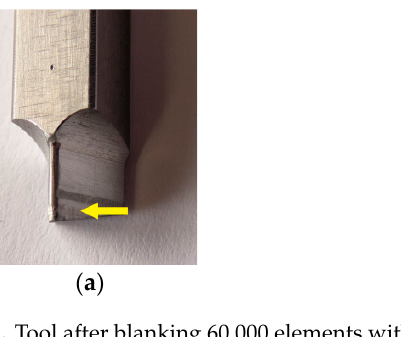
Figure 20. A punch with a sloping frontal surface after damage and punch material separation ( C = 5%, 65,000 cuts).